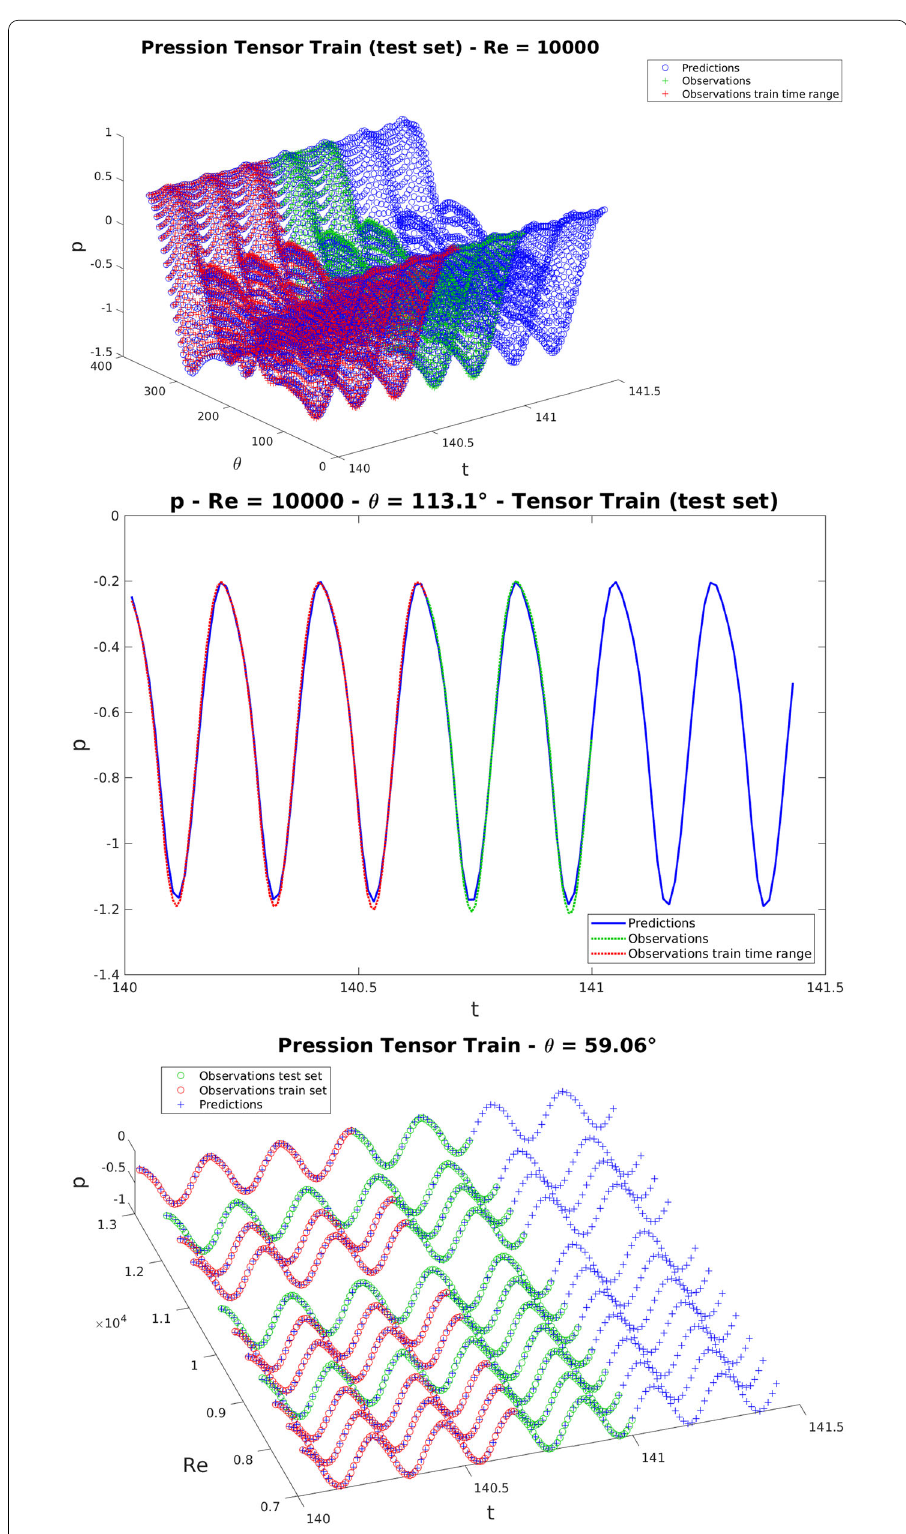
Fig. 4 High Reynolds numbers. Observations and predictions with respect to time for fixed values of the other parameters. The predictions are obtained using tensor formats combined with constrained changes of